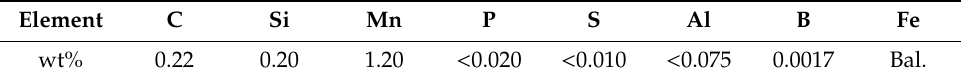
Table 1. Chemical compositions of 15B22.